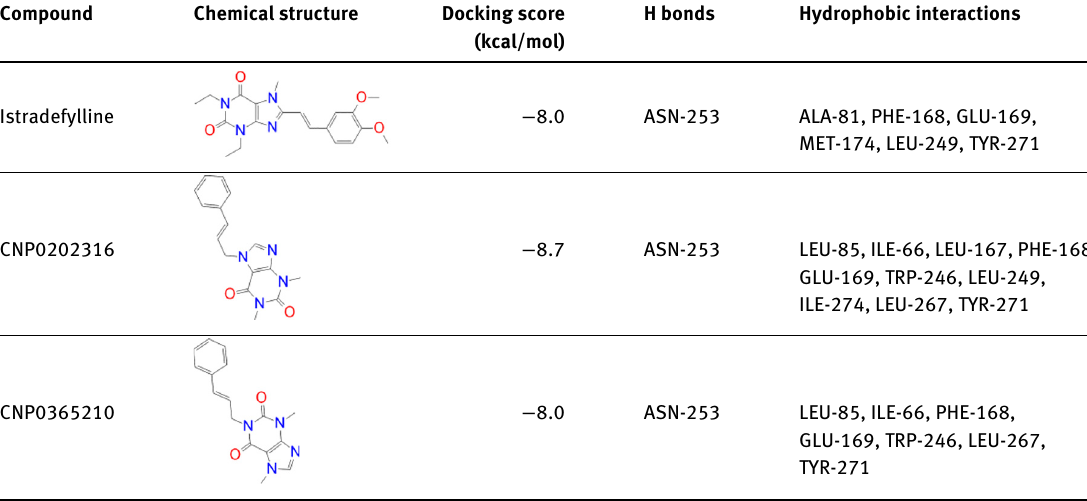
Table 3: Molecular docking results and protein-ligand interactions of selected lead compounds with AA 2A